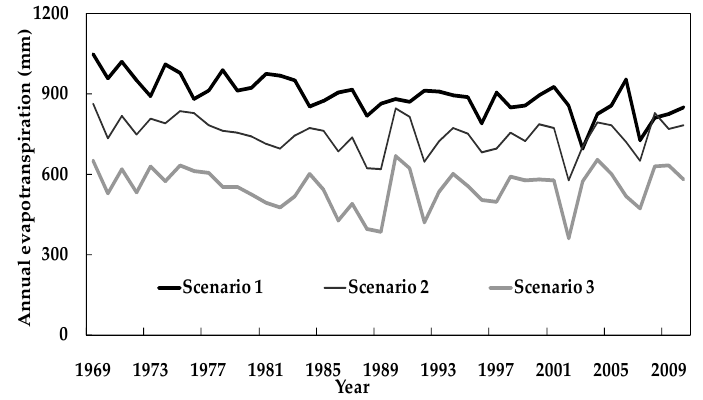
Figure 8. Annual variation in ET under different scenarios from 1969 to 2010.